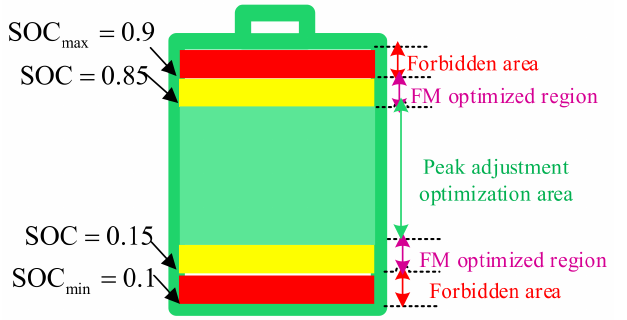
Figure 3. State definition of